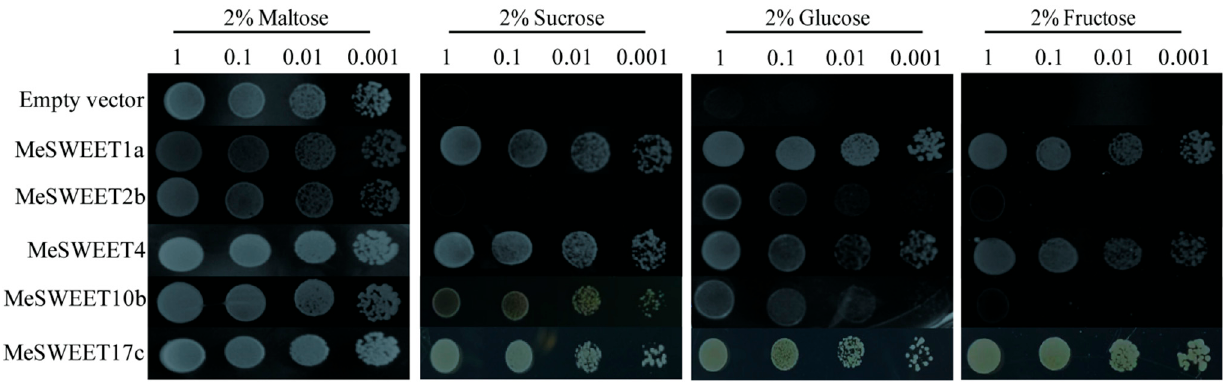
Figure 6. Transport activity of five MeSWEETs in the yeast mutant EBY.VW4000. Yeast cells expressing